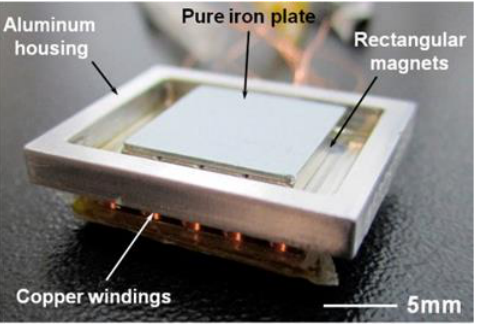
Figure 7. The device created by [62]. The aluminum housing allows the rectangular magnets to float on a thin layer of ferrofluid.